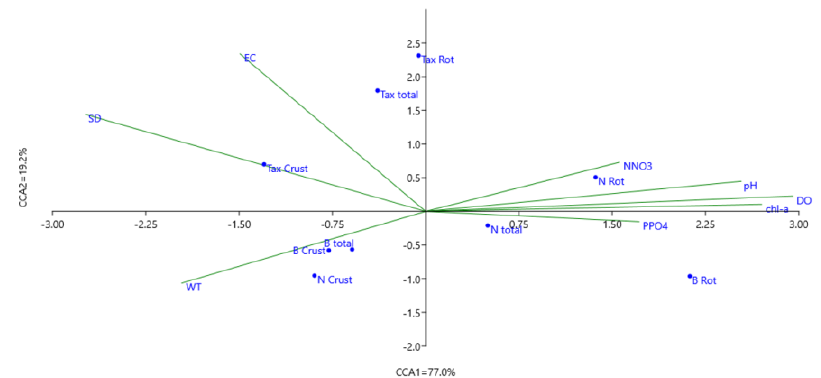
Figure 4. Results of canonical correspondence analysis (CCA) performed on zooplankton and environmental data during vegetation season in the Noteć Canal using forward selection of variables ( p < 0.05). Triplot of significant environmental variables (water temperature: WT, Secchi disk visibility: SD, conductivity: EC, oxygen concentration: DO, pH, chlorophyll: chl- a , nitrate: NNO 3 − , phosphate: PPO 42 − ), number of zooplankton species (Tax total, Tax Rot, Tax Crust), zooplankton density (N total, N Rot, N Crust), and zooplankton biomass (B total, B Rot, B Crust).